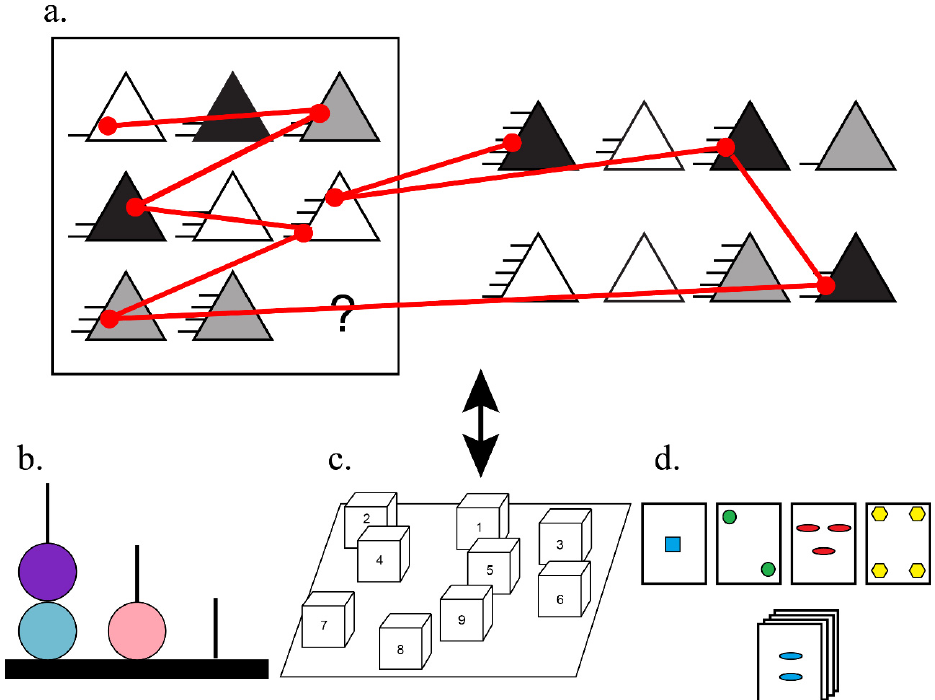
Figure 3. An example of ( a ) a WMT-2 item with an example of eye gaze (in red). The eye gaze metrics were correlated with the ( b ) Tower of London test, ( c ) Corsi block-tapping test, and ( d ) Wisconsin Card-Sorting